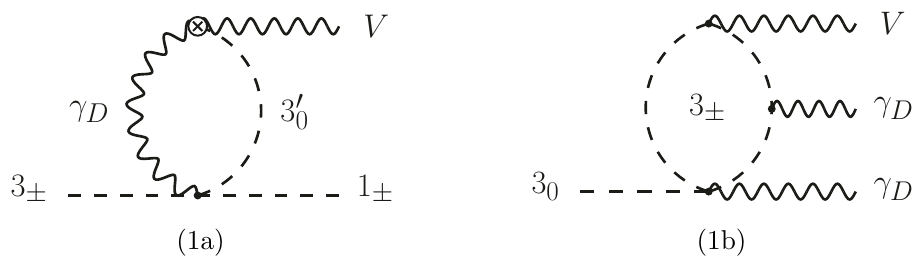
Figure 1 . On the left (1a): Feynman diagram for the decay 3 ± → 1 ± V . The crossed vertex denotes the anomalous interaction. On the right (1b): one of the Feynman diagrams mediating the decay 3 0 → γ D γ D V